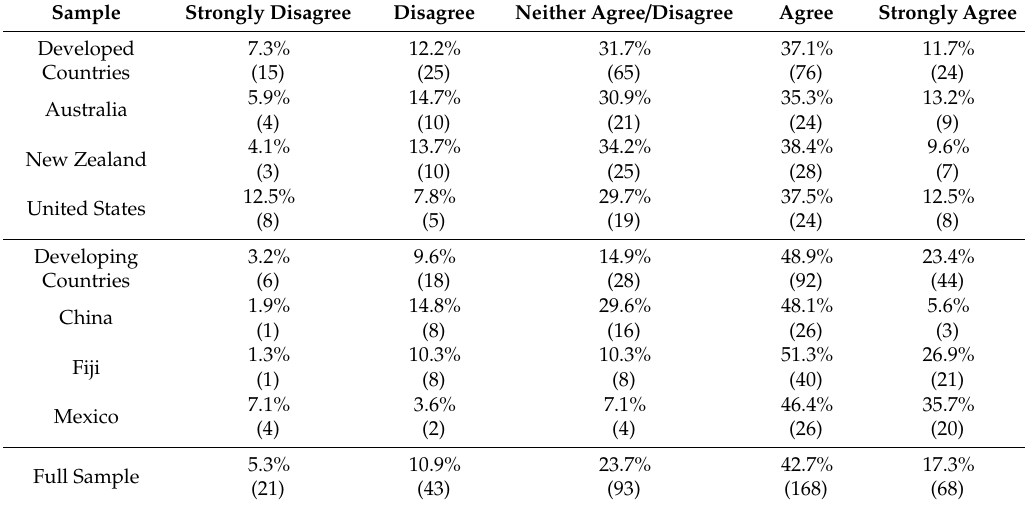
Table 11. Frequency of agreement level on item: personally, I feel that I can make a di ff erence with regard to climate change.